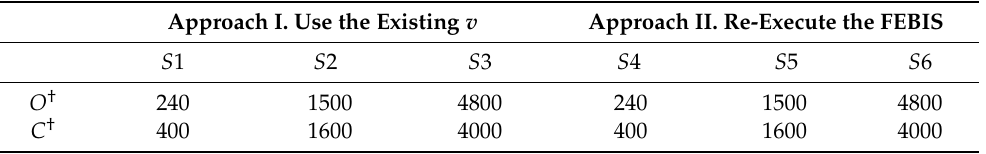
Table 3. Data of the new ICEB B † to join the egg banking alliance A for scenarios S 1 ∼ S 6. Approach I. Use the Existing v